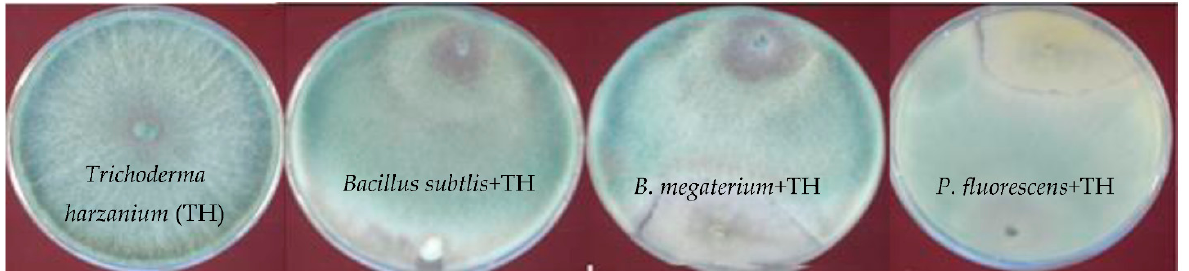
Figure 2. Photographs showing the synergistic interaction between fungi ( T. harzanium ) and the bacterial strains. The strains Bacillus subtlis (BS), B. megaterium (BM) and Pseudomonas fluorescens (PF) were juxtaposed against T. harzanium (TH). The bioinoculants assayed for in vitro interactions showed no significant antagonistic activity against each other.